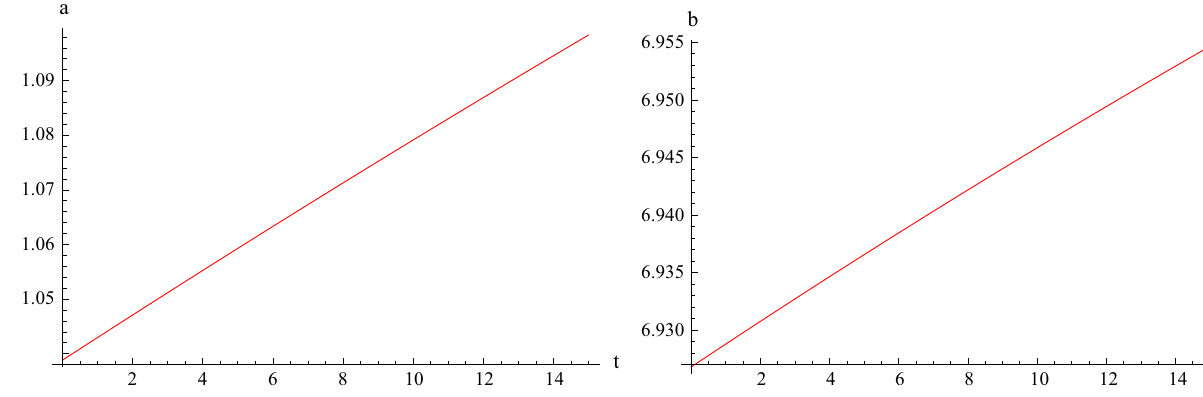
Fig. 5 Plots of scale factor a ( t ) ( left ) and b ( t ) ( right ) versus cosmic time t for c 2 = c 3 = c 9 = 5 . 5 and c 10 = 0 . 005